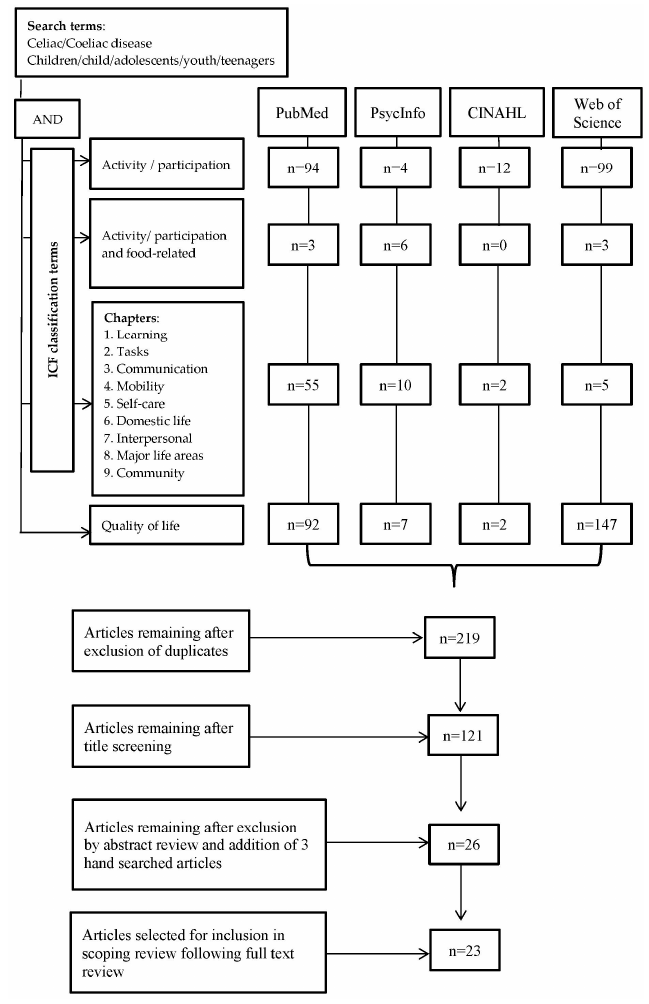
Figure 2. Flow diagram describing the search and inclusion process.